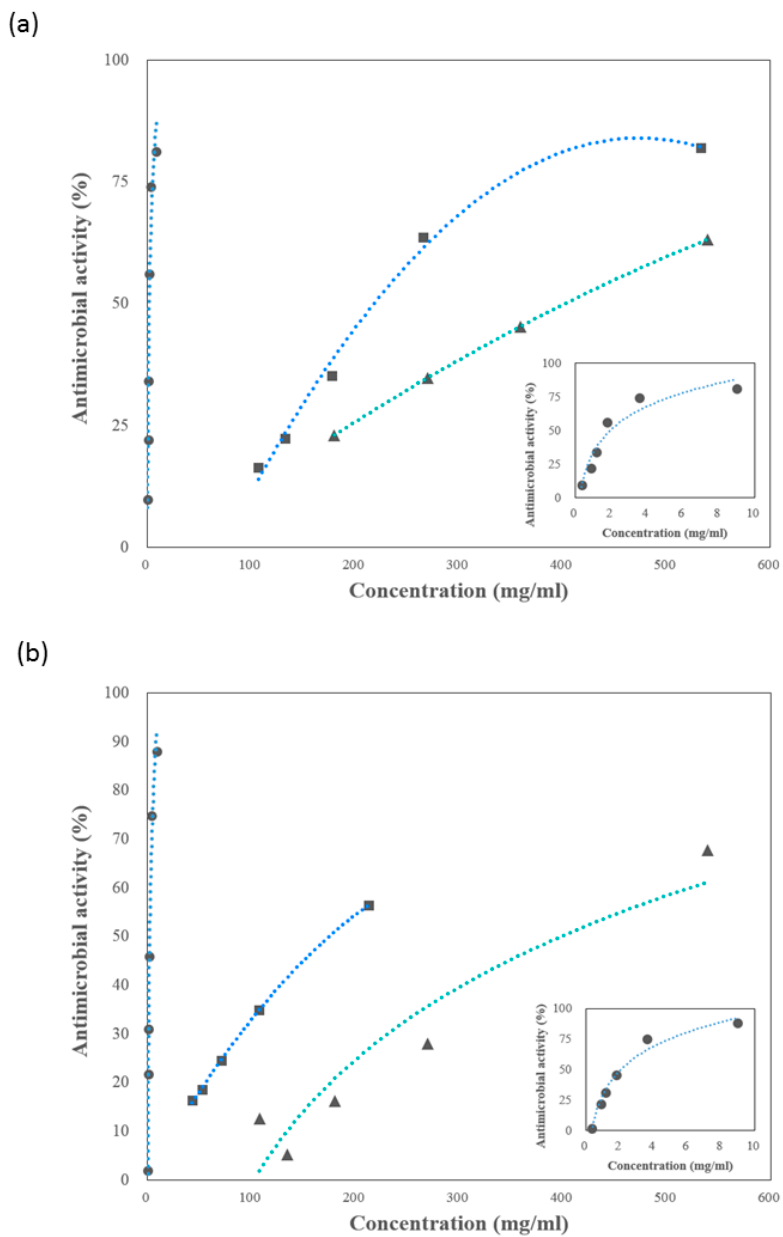
Figure 2. Cell inactivations of ( a ) Micrococcus luteus and ( b ) Escherichia coli depending on the concentrations of plant extracts of tea-tree oil ( • ), rosemary ( (cid:4) ), and garlic ( (cid:78) ). The graph in the inset presents the enlarged graph of tea-tree